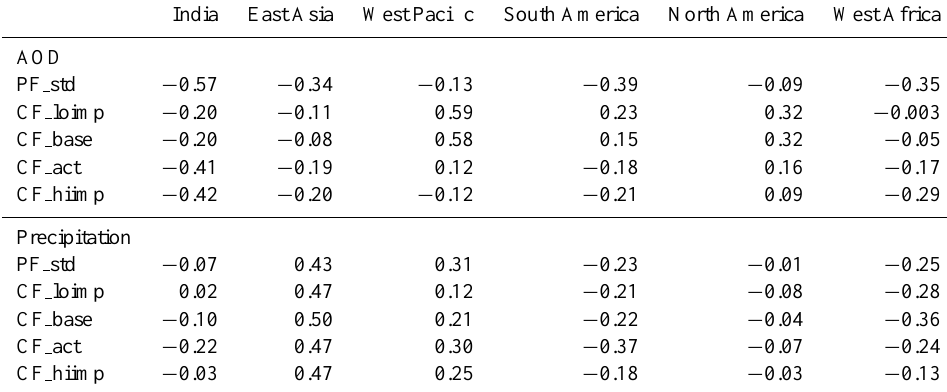
Table A1. Mean fractional bias between the regional, monthly mean aerosol optical depth (AOD) retrieval of van Donkelaar et al. (2010) and the five simulations (top half of table). Mean fractional bias between the regional, monthly mean precipitation of the Global Precipitation Climatology Project retrieval (Adler et al., 2003; Hoffman et al., 2009) and the five simulations (bottom half of table). Seasonal cycles are shown in Fig.